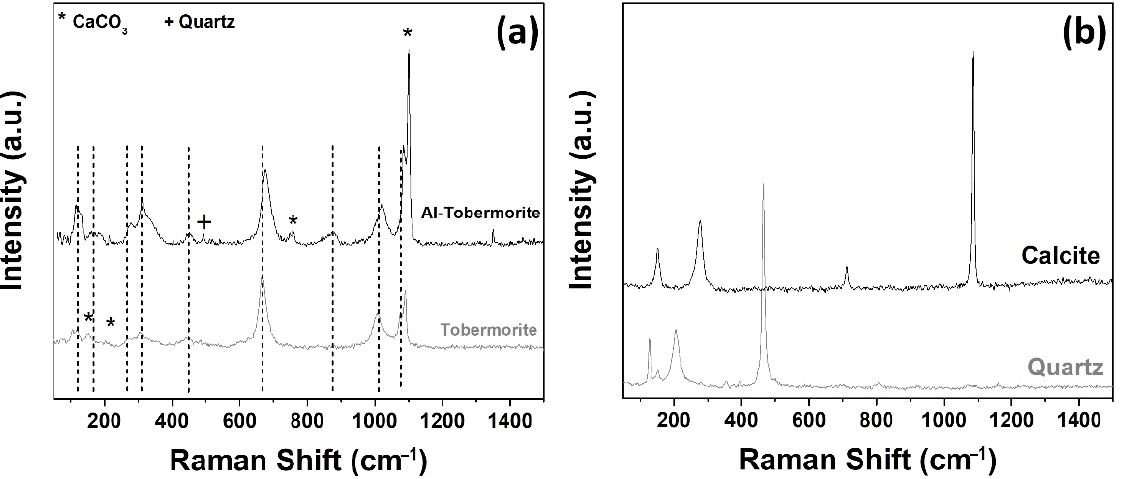
Figure 7. Raman spectra of the phases detected in the GMW-FA-CR mixture after 28 days of curing: ( a ) CSH and CASH, ( b ) calcite and quartz.